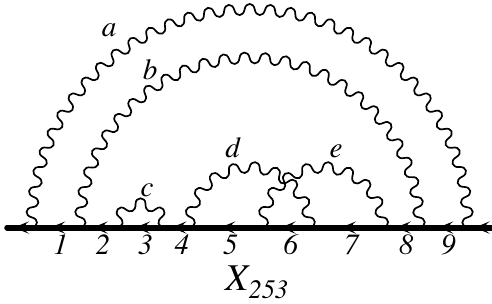
Figure 7. A tenth-order self-energy-like diagram. This is one of the diagrams V of Figure 5. The solid and wavy lines represent electron and photon propagators, respectively. Reprinted from